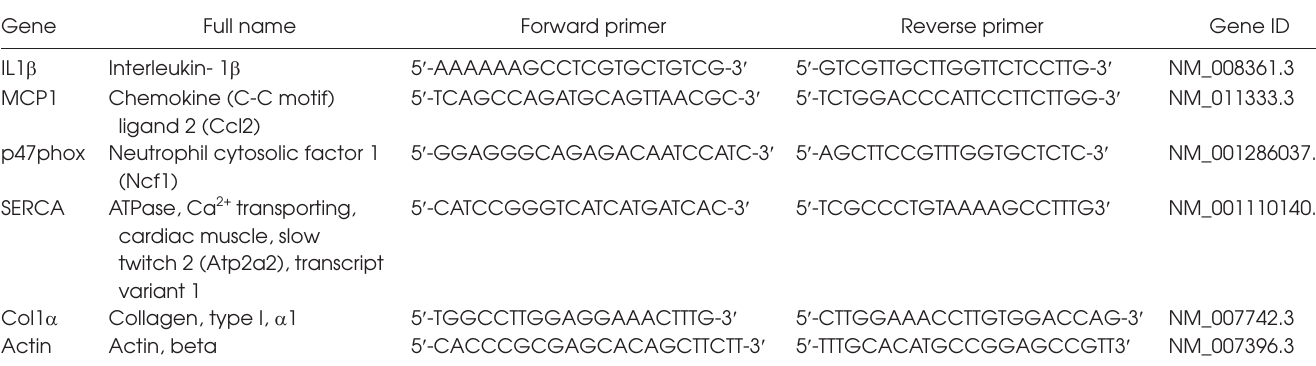
Table 2. Primer sequences for IL1 β , MCP1, p47phox, SERCA, Col1 α and